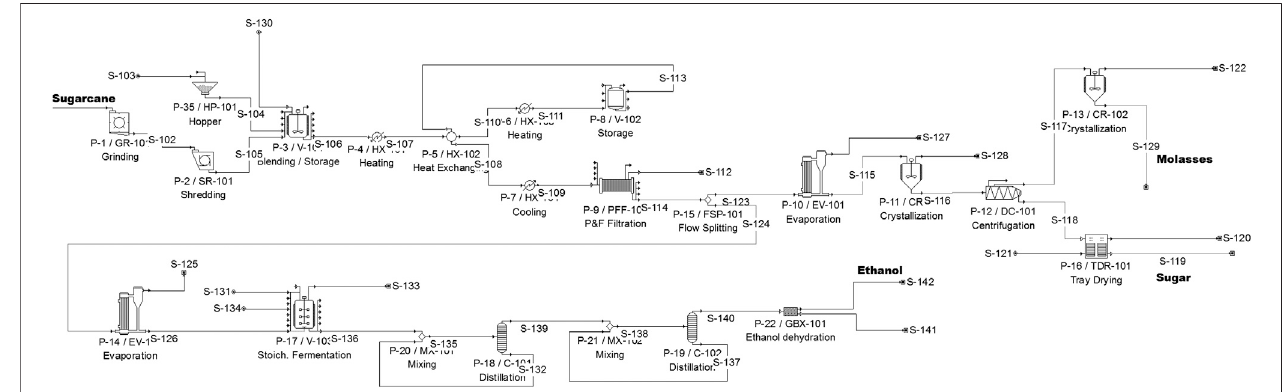
FIGURE 2 | Simulation fl owsheet of the sugar, molasses, and ethanol production. Process in SuperPro Designer ® .